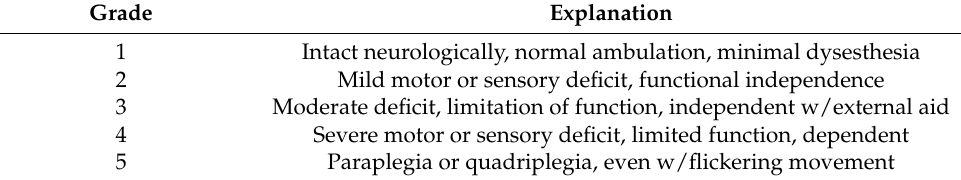
Table 1. Modified McCormick scale explanation.